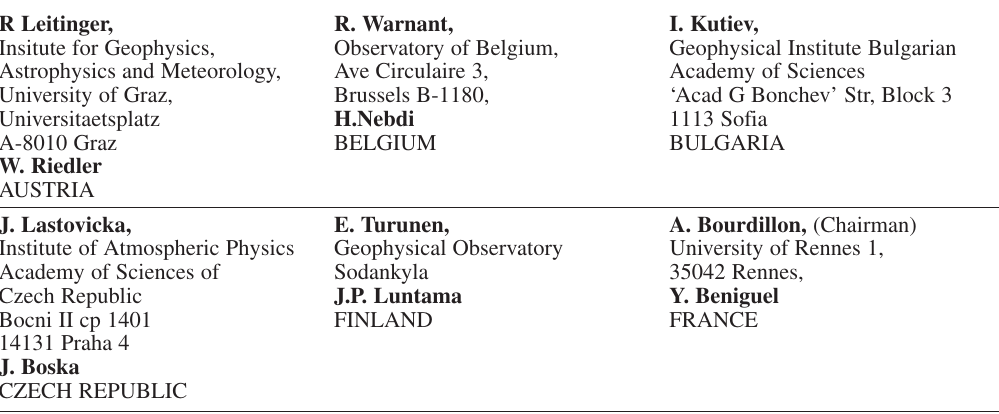
Table II. Members of the COST 296 Management Committee R